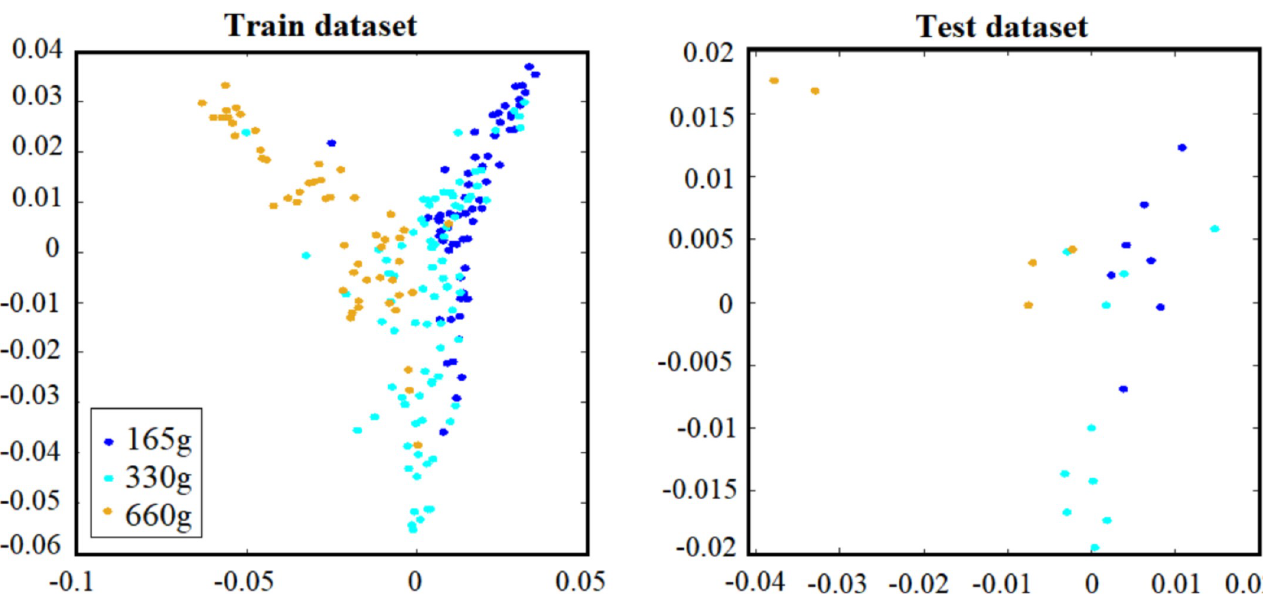
Fig 5. Example of an out-of-sample extension via the Nystro¨m approximation in embedded space by Laplacian Eigenmaps with k = 8 and σ = 1. The train/ test ratio was